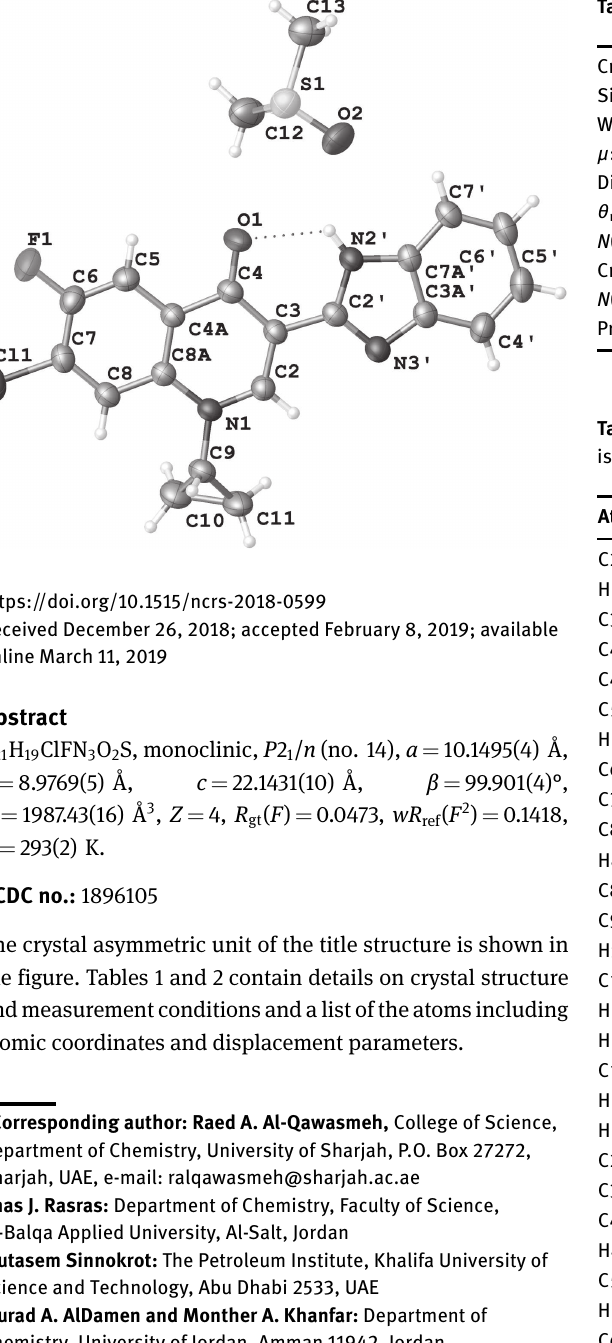
Table 1: Data collection and handling.